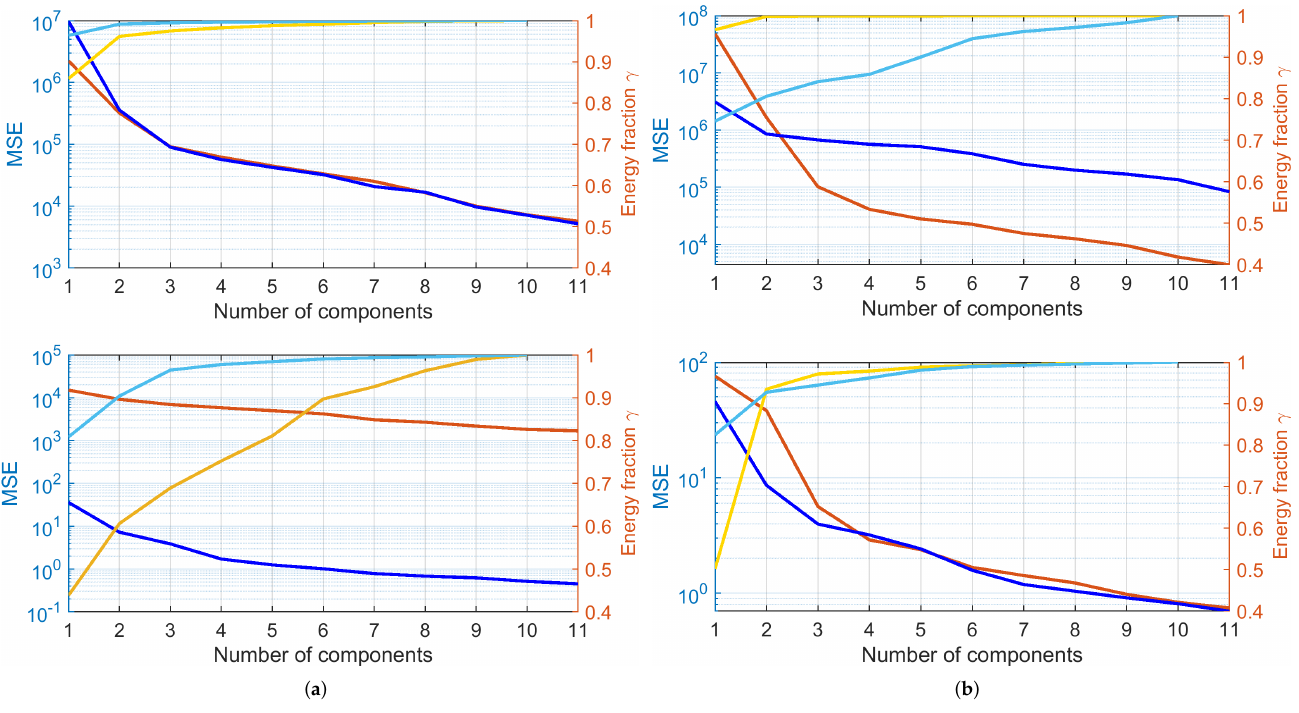
Figure 14. PLSR results for fitting quality (mean square error, MSE) and cumulative energy fraction γ : ( a ) traction and braking classes for Switzerland; ( b ) distinction of the three rolling stock for Switzerland, Germany, and France (traction and braking conditions altogether). P h (brown dark and light), and Q h (blue dark and light) above, V h (brown dark and light), and I h (blue dark and light)